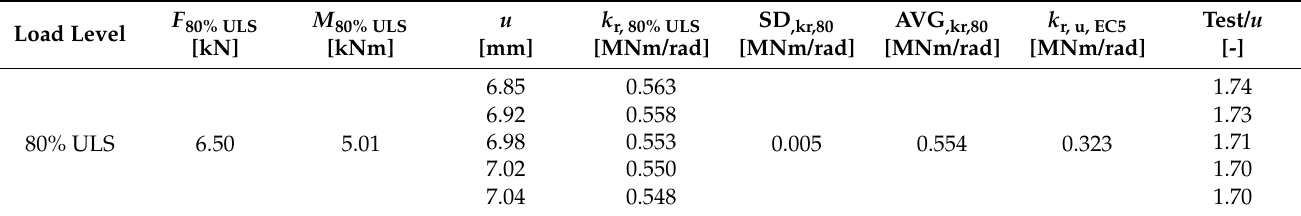
Table 7. Results of quasi-static cyclic testing for Experiment A at 80% ULS.